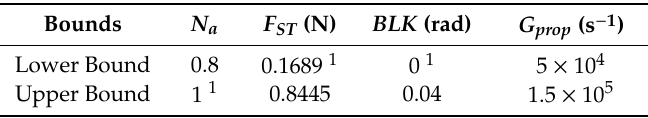
Table 1. Summary of bounds considered for